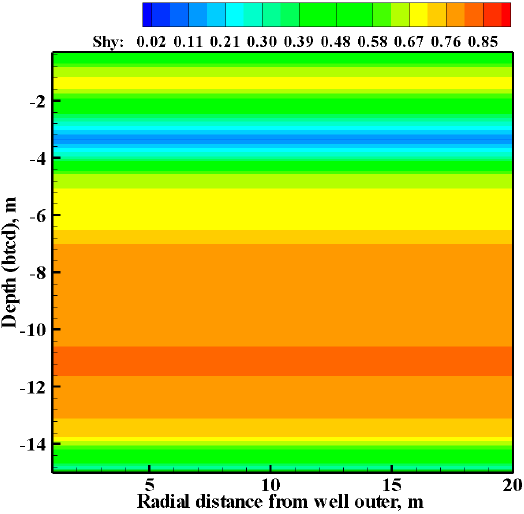
Figure 6. Initial saturation of the hydrate phase.